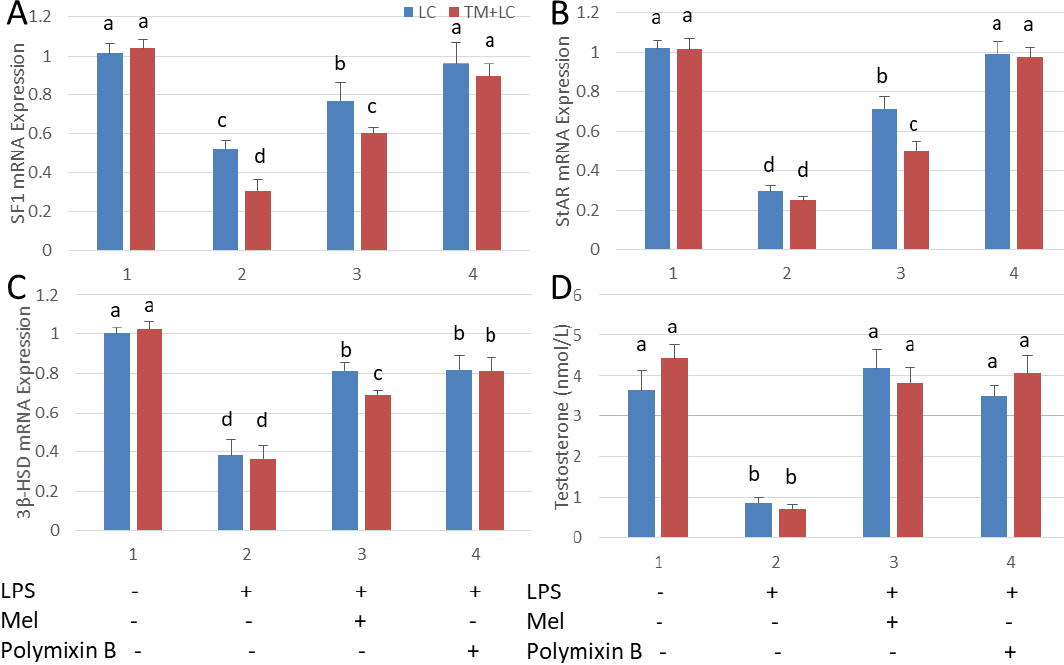
Figure 6. Melatonin increases testosterone content in an LPS-induced Leydig cell co-cultured system with testicular macrophages. qRT-PCR detection ( A ) SF1, (B) StAR, ( C ) mRNA expression and ( D ) testosterone levels in Leydig cell (LC) and in co-cultures with testicular macrophages (TM) detected by ELISA. Cell treated with LPS, Mel and / or polymixin B. Data are shown as mean ± SEM. Different superscript letters (a–d) in each column representative statistically significant differences ( p < 0.05).